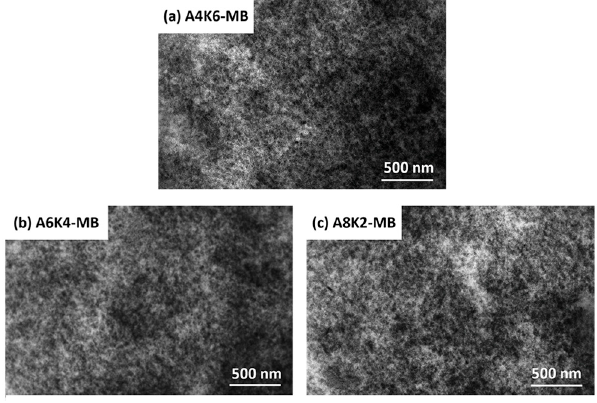
Figure 9. TEM images of ( a ) A4K6-MB; ( b ) A6K4-MB; and ( c ) A8K2-MB.